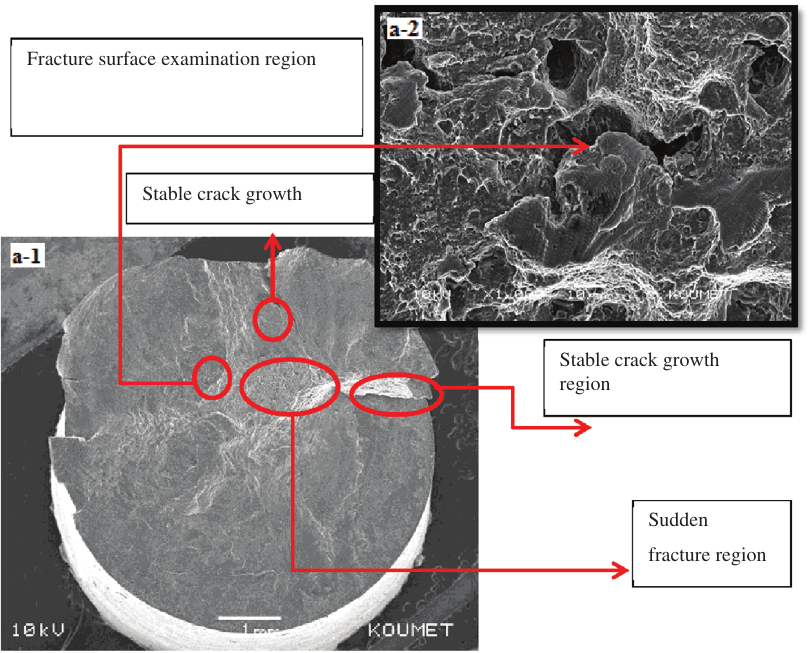
Figure 8: The SEM image of fracture surface morphology of casting AA7075 after high-cycle fatigue test.